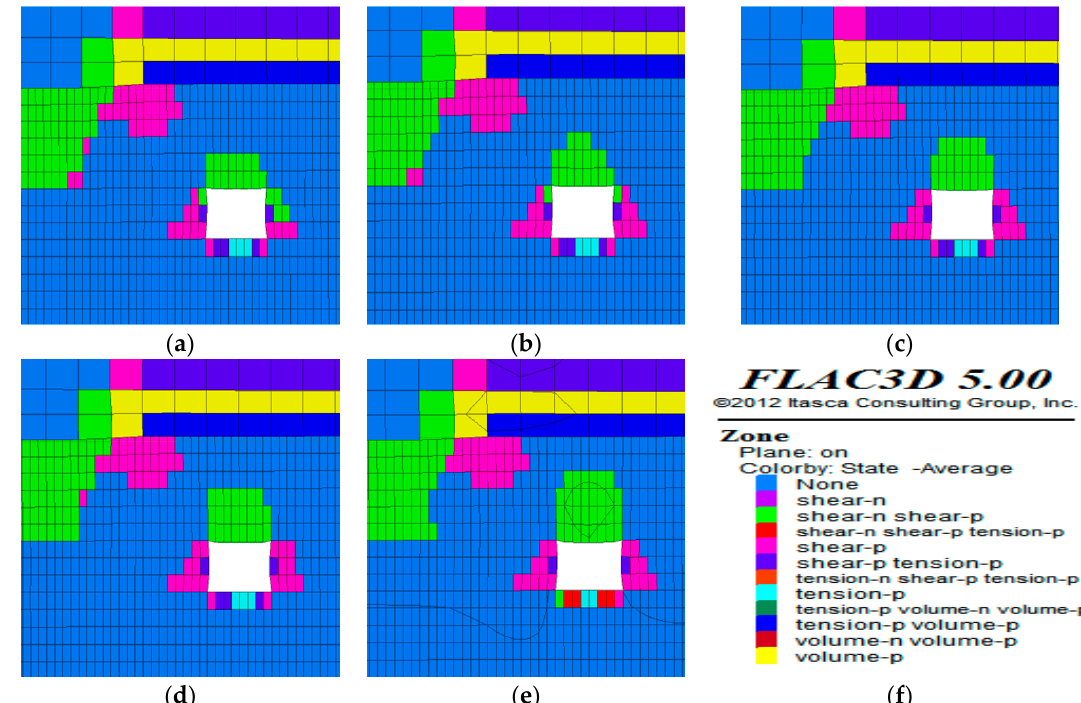
Figure 13. Range of the plasticity zone of the roadway with different line spacing of the bolts. ( a ) 0.6 m; ( b ) 0.7 m; ( c ) 0.8 m; ( d ) 0.9 m; ( e ) 1.0 m; ( f ) Rock failure state.